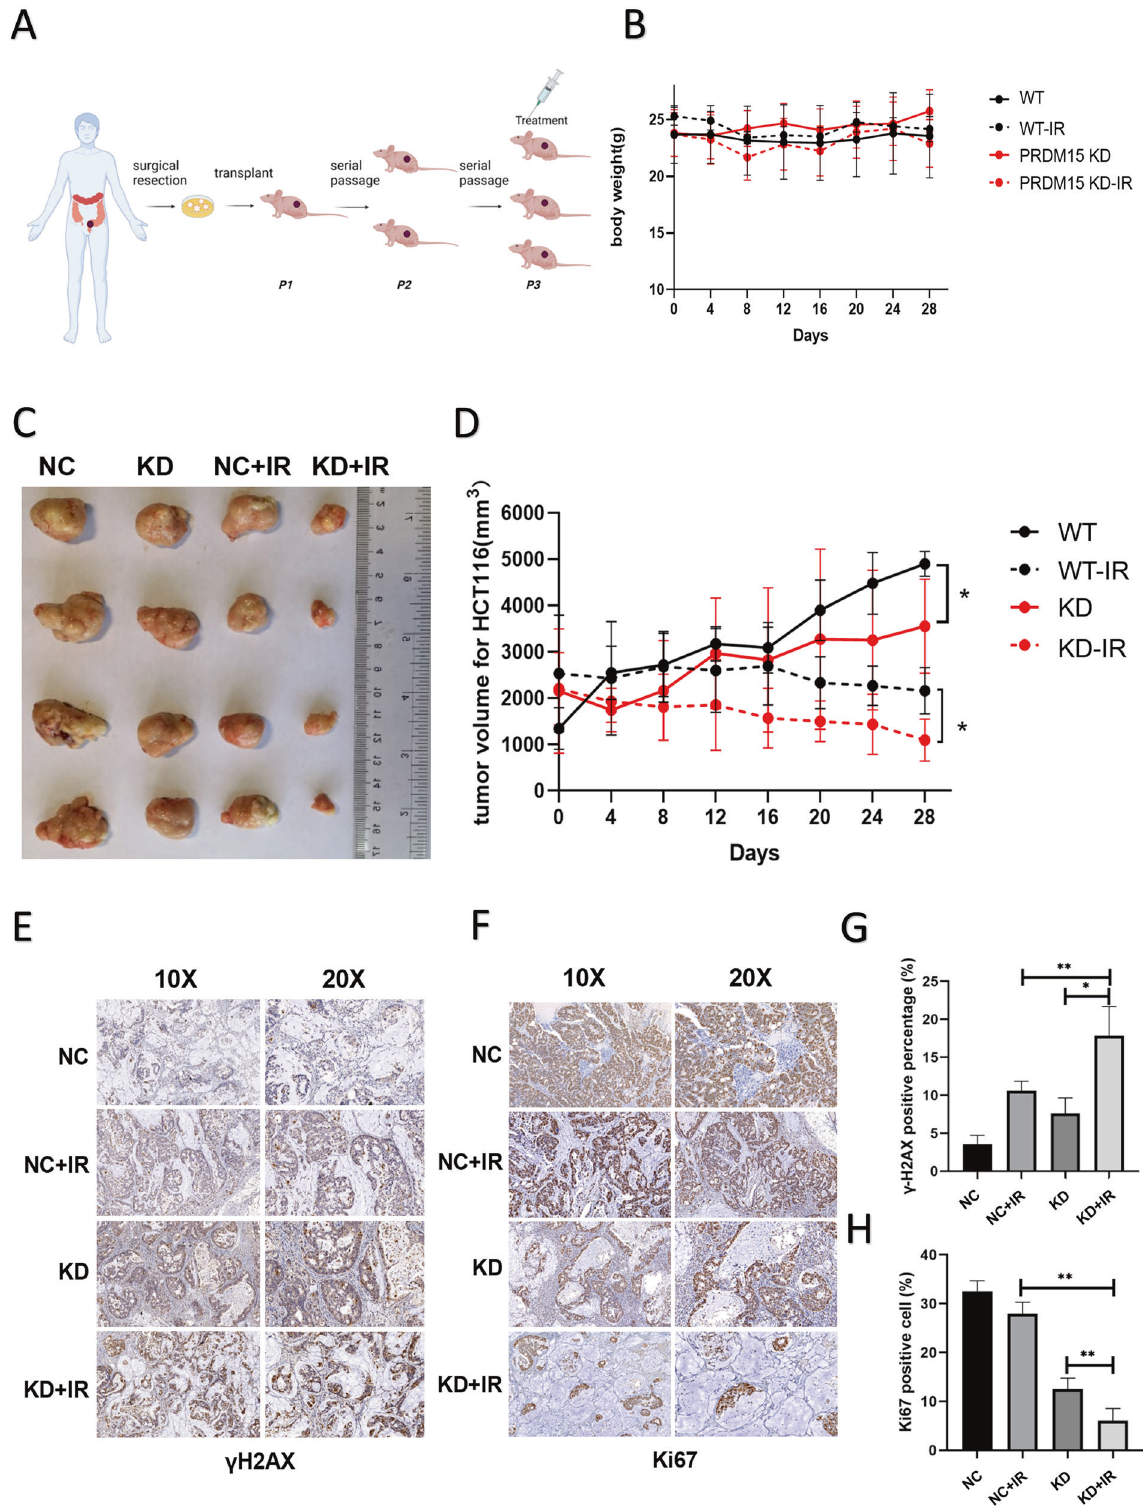
Fig. 7 PRDM15 promotes the radioresistance of CRC in PDX models. A Schematic diagram of PDX model construction. B Mice weight monitoring of PDX models after radiotherapy. C Representative images of xenograft tumors in different groups at 28 days after 15 Gy local radiotherapy in pelvic cavity. D Tumor volume growth from the PRDM15-NC and PRDM5-KD groups with/without IR. Error bars represent the SD of the mean of four independent animals. two tailed Student ’ s t test was applied in NC and KD groups with the same intervention. * P < 0.05, ** P < 0.01, *** P < 0.001 and **** P < 0.0001 versus untreated control. E , F Representative 10× and 20× images of γ -H2AX and Ki67 immunohistochemical staining of tumor tissue sections in different groups at 12 h after 15 Gy local radiotherapy in pelvic cavity. G , H Respective percentage of γ -H2AX ( + ) and Ki67 ( + ) cells in tumor by quantitative analysis. Data are shown as the mean ± SD, one-way ANOVA, * P < 0.05, ** P < 0.01 and *** P < 0.001. Cell Death and Disease (2022)